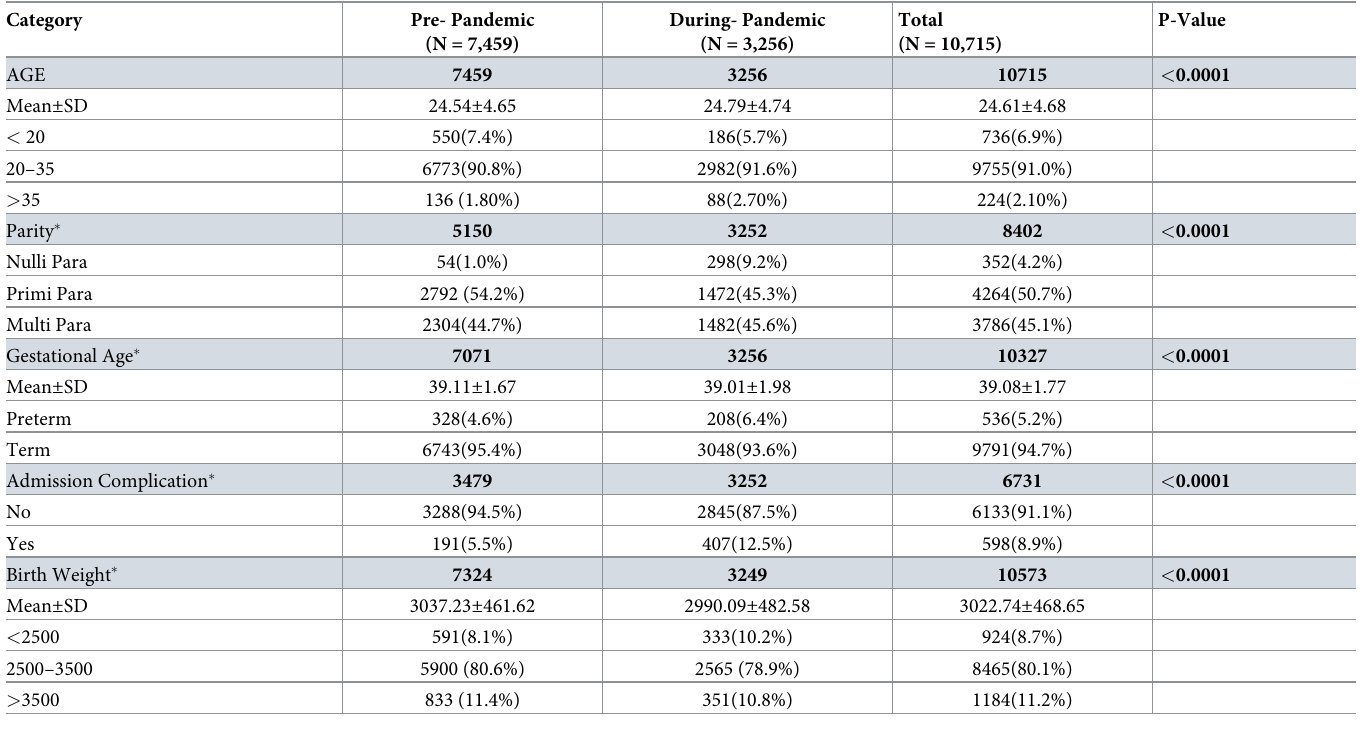
Table 3. Demographic and obstetric characteristics of women delivering in the hospital.